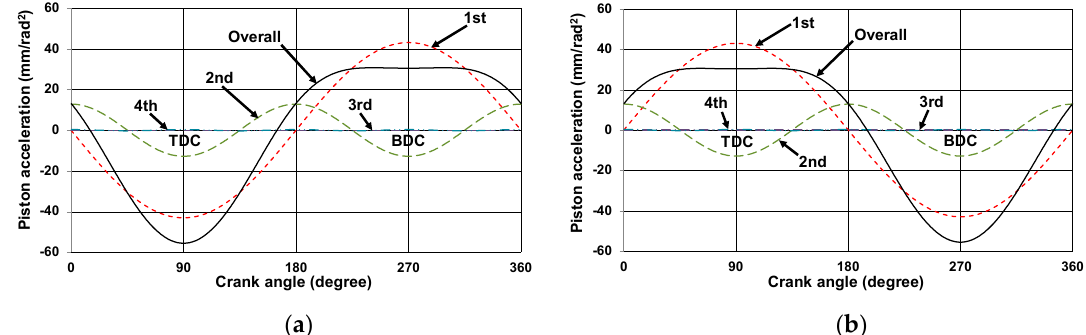
Figure 2. Harmonic acceleration components at the piston pin of slider-crank mechanism: ( a ) Cylinder 1 and ( b ) Cylinder 2.